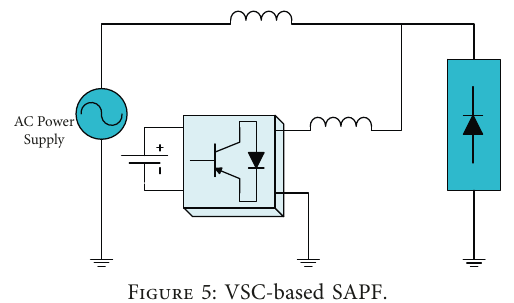
Figure 5: VSC-based SAPF.